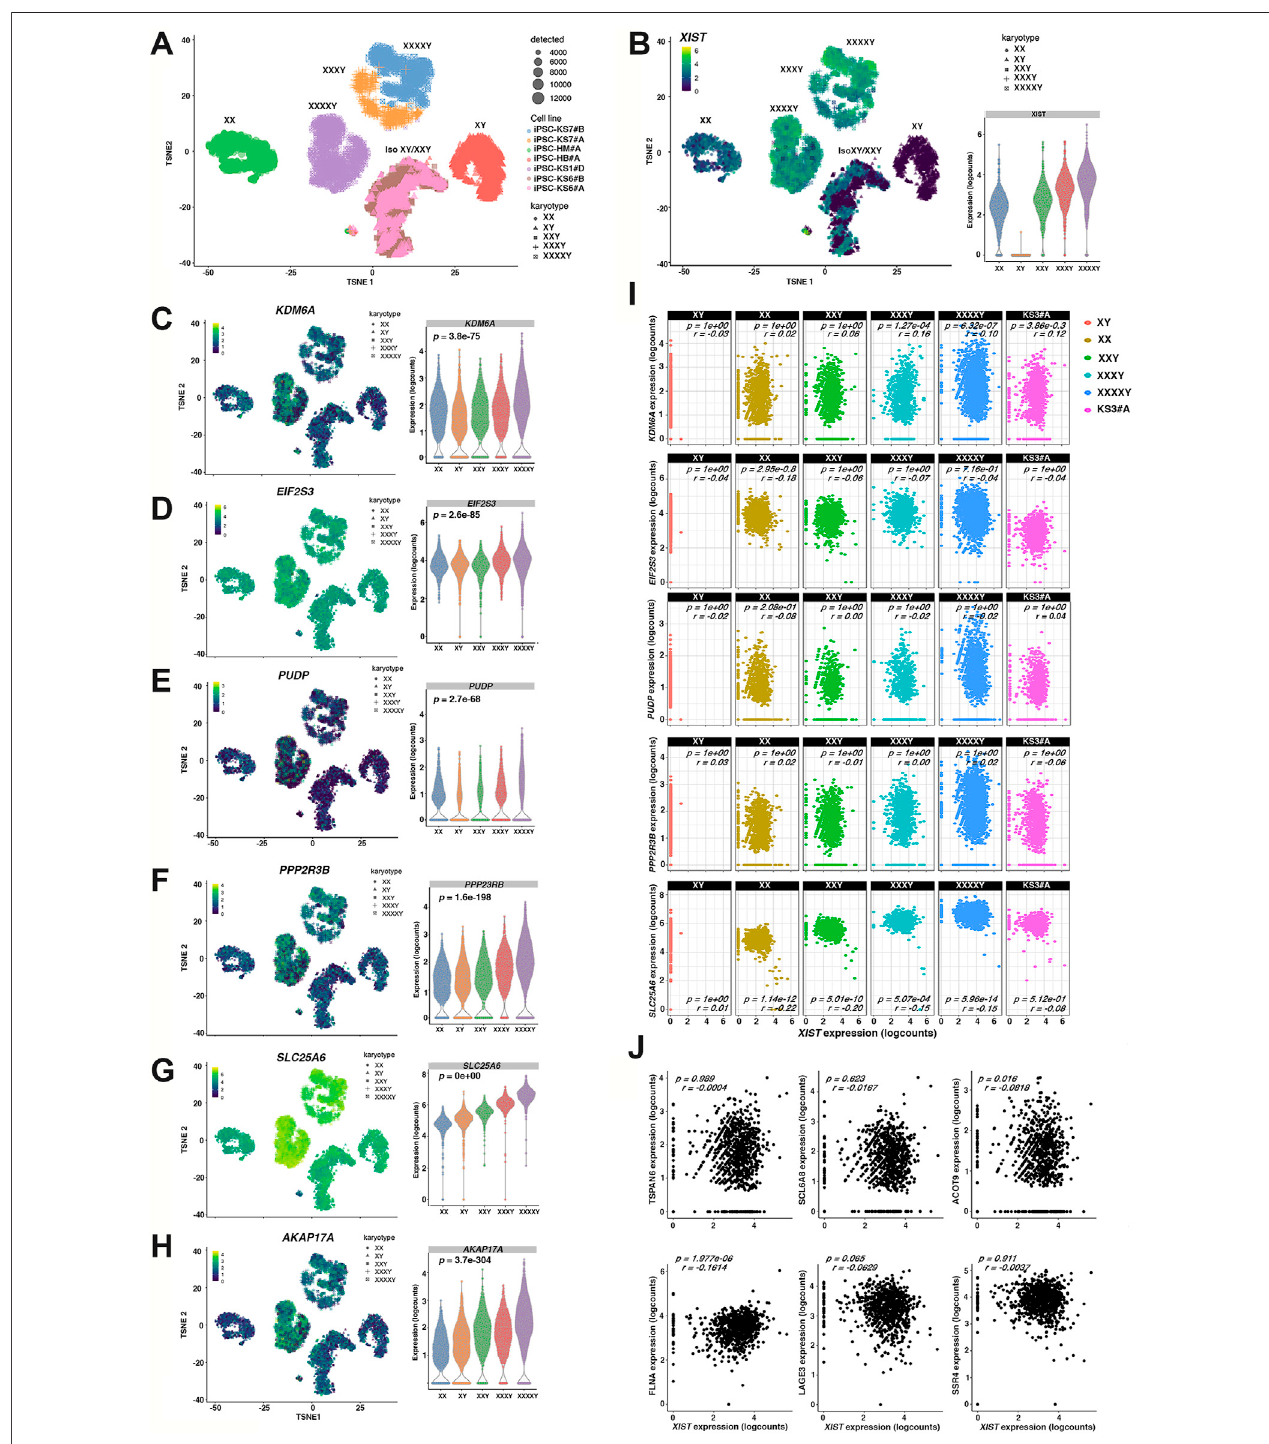
FIGURE 4| Single-cell RNA-sequencing ofKS, HGA and controls iPSCs reveals homogenousXIST expression mirroring the X dosage and XIST-independency of escape genes on Xi. (A) t-Distributed stochastic neighbor embedding (t-SNE) plots of the whole-genome transcriptome for seven scRNA-Seq in 46,XX, 46,XY, 47,XXY, 48,XXXY, and 49,XXXXY hiPSCs. Circle sizes represent the number of detected genes/cells. A detailed description of the number of cells and the average number of genes detected for each sample is reported in Supplementary Table S12 . Iso, Isogenenic cell line (B) Left: Expression pro fi les for the lncRNA XIST , right: Violin plot of XIST expression in the analyzed karyotypes. (C – H) Expression pro fi les for the indicated dosage-sensitive non-PAR escape (C – E) and PAR1 genes (F – H) were visualized by t-SNE (left) and Violin plots (right). The signi fi cance was calculated with the non-parametric Kruskal-Wallis statistical test. (I) Scatter plots showing the